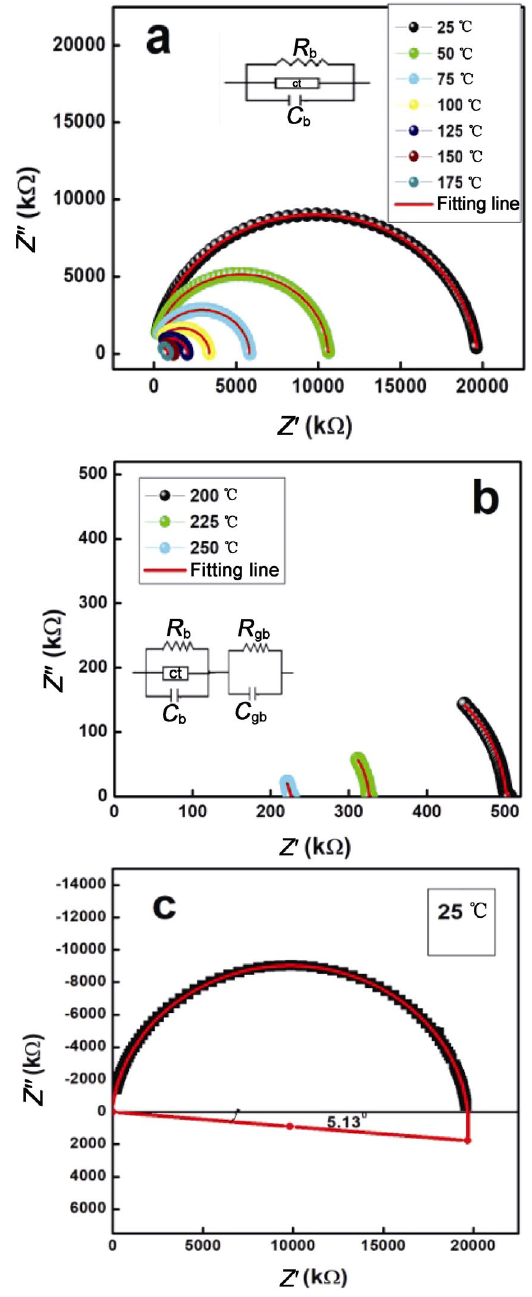
Fig. 6 Variation of Z ′ with Z ″ : (a) 25–175 ℃ , (b) 200– 250 ℃ , and (c) 25 ℃ with depression